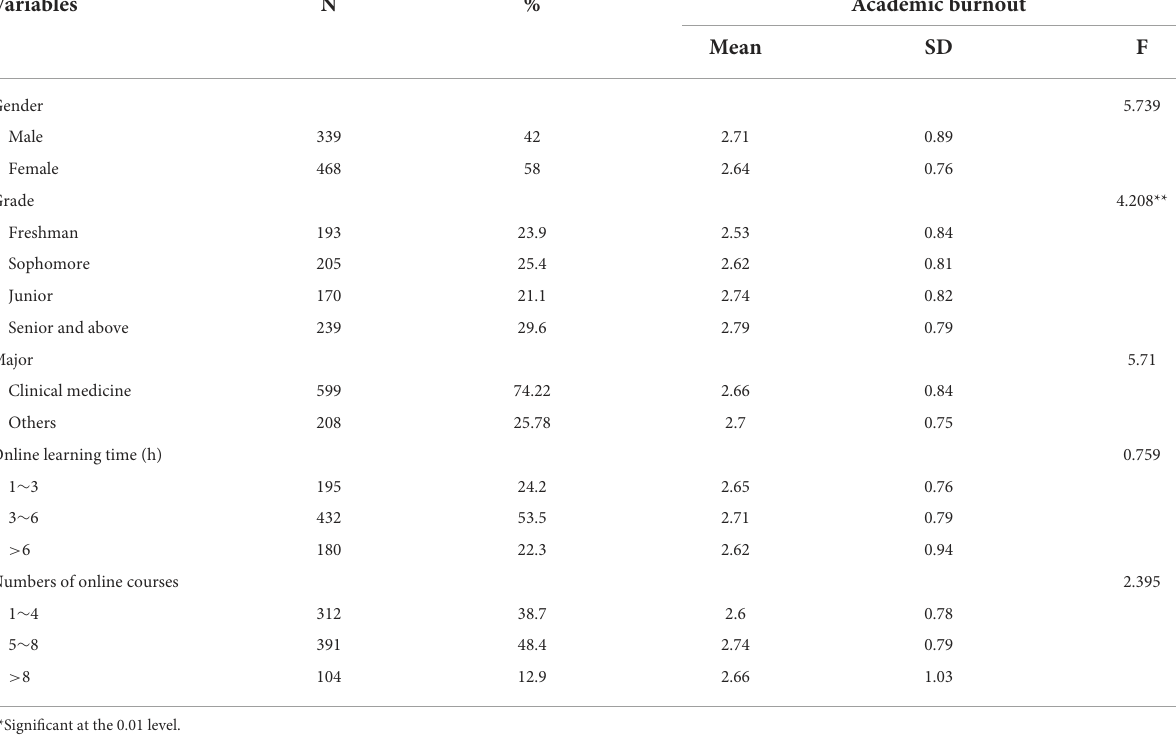
TABLE 4 Descriptive analysis and differences in academic burnout among medical students ( N = 807).